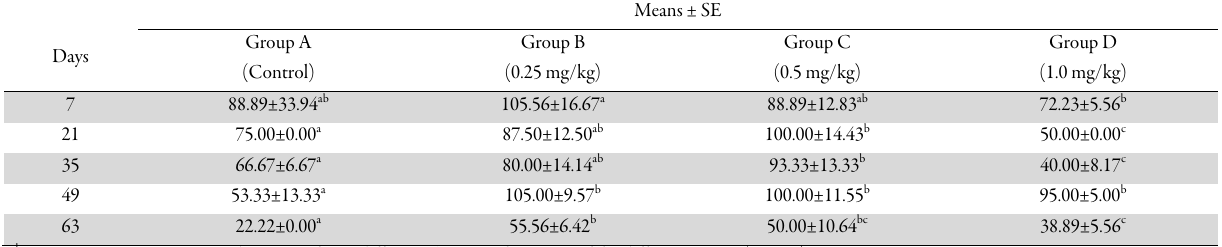
Table 5. Mean serum triglyceride concentration (mg/dl) of albino rats given graded doses of whole quail egg per kilogram body weight (± SEM)